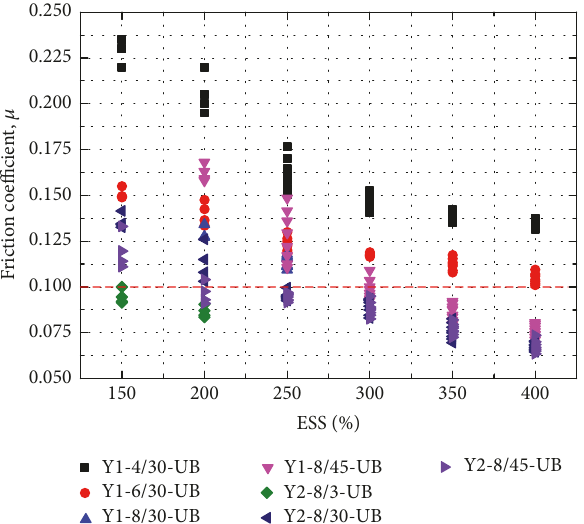
Figure 7: Observed friction versus increasing ESS.